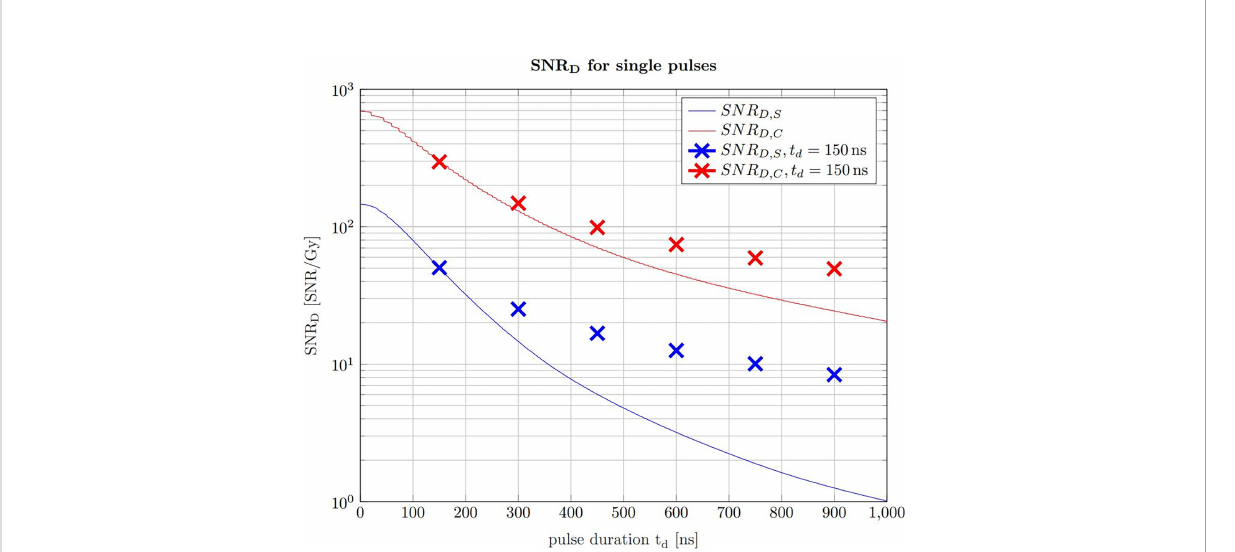
FIGURE 9 The SNR D,S (solid blue line) and the SNR D,C (solid red line) for non averaged signals at a given dose limit of 1 Gy. With increasing pulse duration, the beam current decreases correspondingly to ensure the constant dose limit. The crosses indicate the SNR D,S/C that is expected using a pulse duration of 150 ns at the same beam current as the single pulses and use averaging to ensure the dose